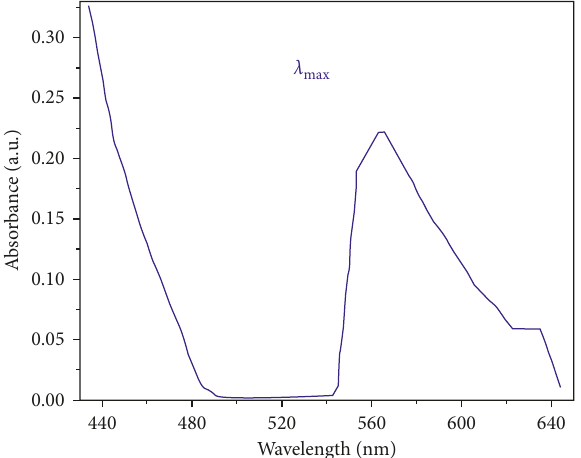
Figure 1: Maximum absorbance ( λ